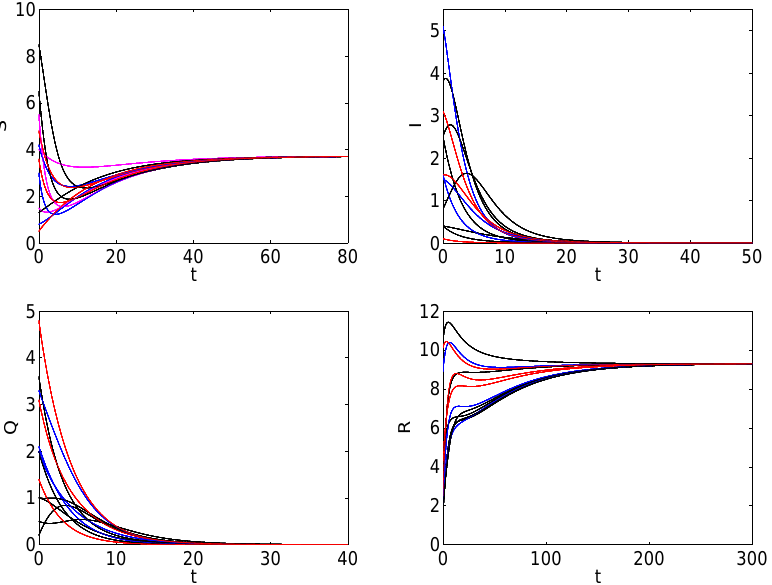
Figure 1. Variational curves of S , I , Q , and R with time t when R 0 = 0.8075 <